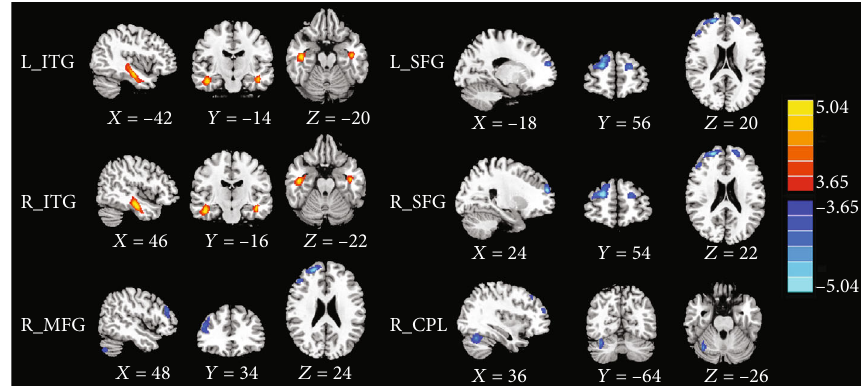
Figure 1: The CBF di ff erences between the mTBI patients and the HC subjects. Compared with HC, the acute mTBI patients showed increased CBF in the bilateral inferior temporal gyrus (ITG) as well as decreased CBF in the bilateral superior frontal gyrus (SFG), right middle frontal gyrus (MFG), and right cerebellum posterior lobe (CPL). Table 2: Brain regions with signi fi cant group di ff erences in normalized